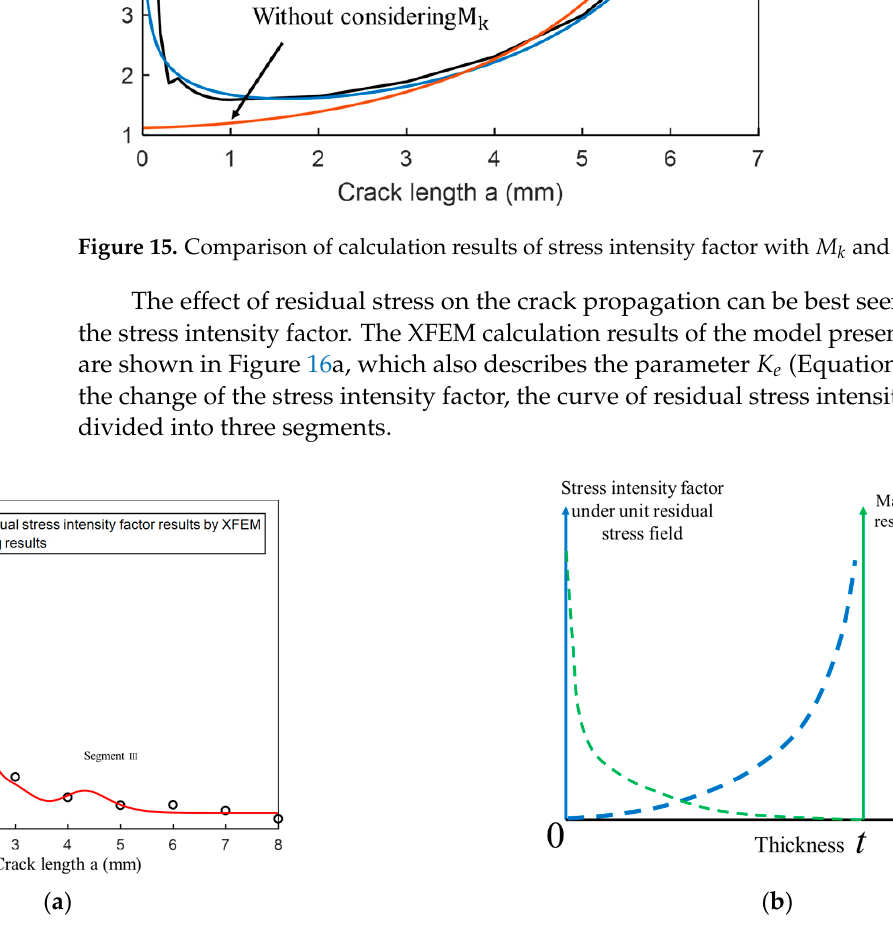
Figure 16. Functional relationship between residual stress intensity factor and crack length a as crack grows. ( a ) Residual stress intensity factor; ( b ) Variation of residual stress and stress intensity factor as crack grows.